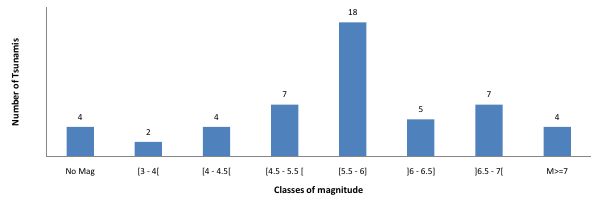
Fig. 5. Number of tsunamis (figure on the top of each column) at- tributed to earthquakes classified per magnitude classes. The upper classes, starting from threshold 5.5, coincide with the DM classes. A “no mag” ( = no magnitude) class is added for earthquakes for which no magnitude estimate can be found in the